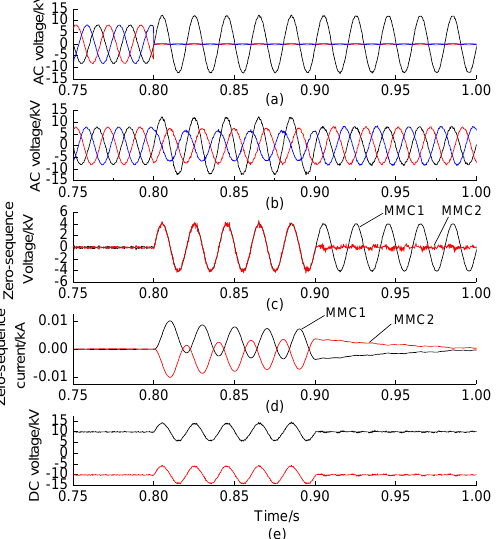
Figure 13. Fault response characteristics of two-phase grounding fault. ( a ) Three-phase AC voltage of MMC1 (black is A-phase, red is B-phase, blue is C-phase). ( b ) Three-phase AC voltage of MMC2 (black is A-phase, red is B-phase, blue is C-phase). ( c ) AC zero-sequence voltage of MMC1 and MMC2 (black is MMC1, red is MMC2). ( d ) AC zero-sequence current of MMC1 and MMC2 (black is MMC1, red is MMC2). ( e ) Positive and negative DC voltage (black is positive DC voltage, red is negative DC voltage).